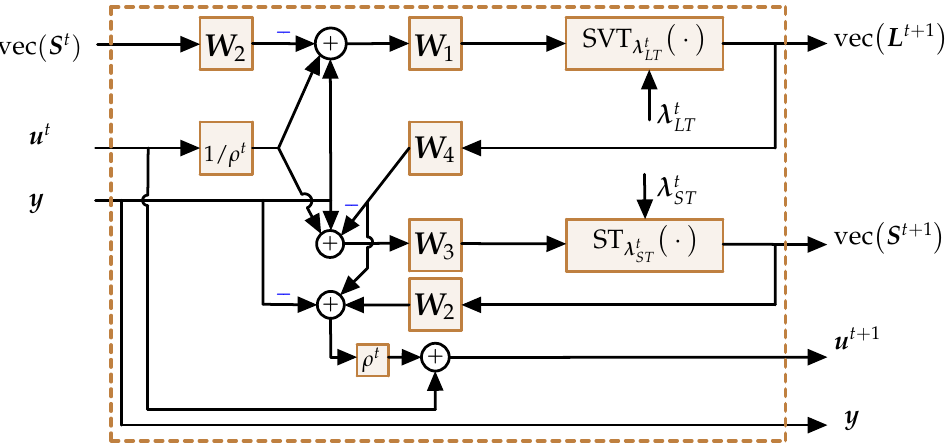
, λ t , γ t , ρ t ) are T S